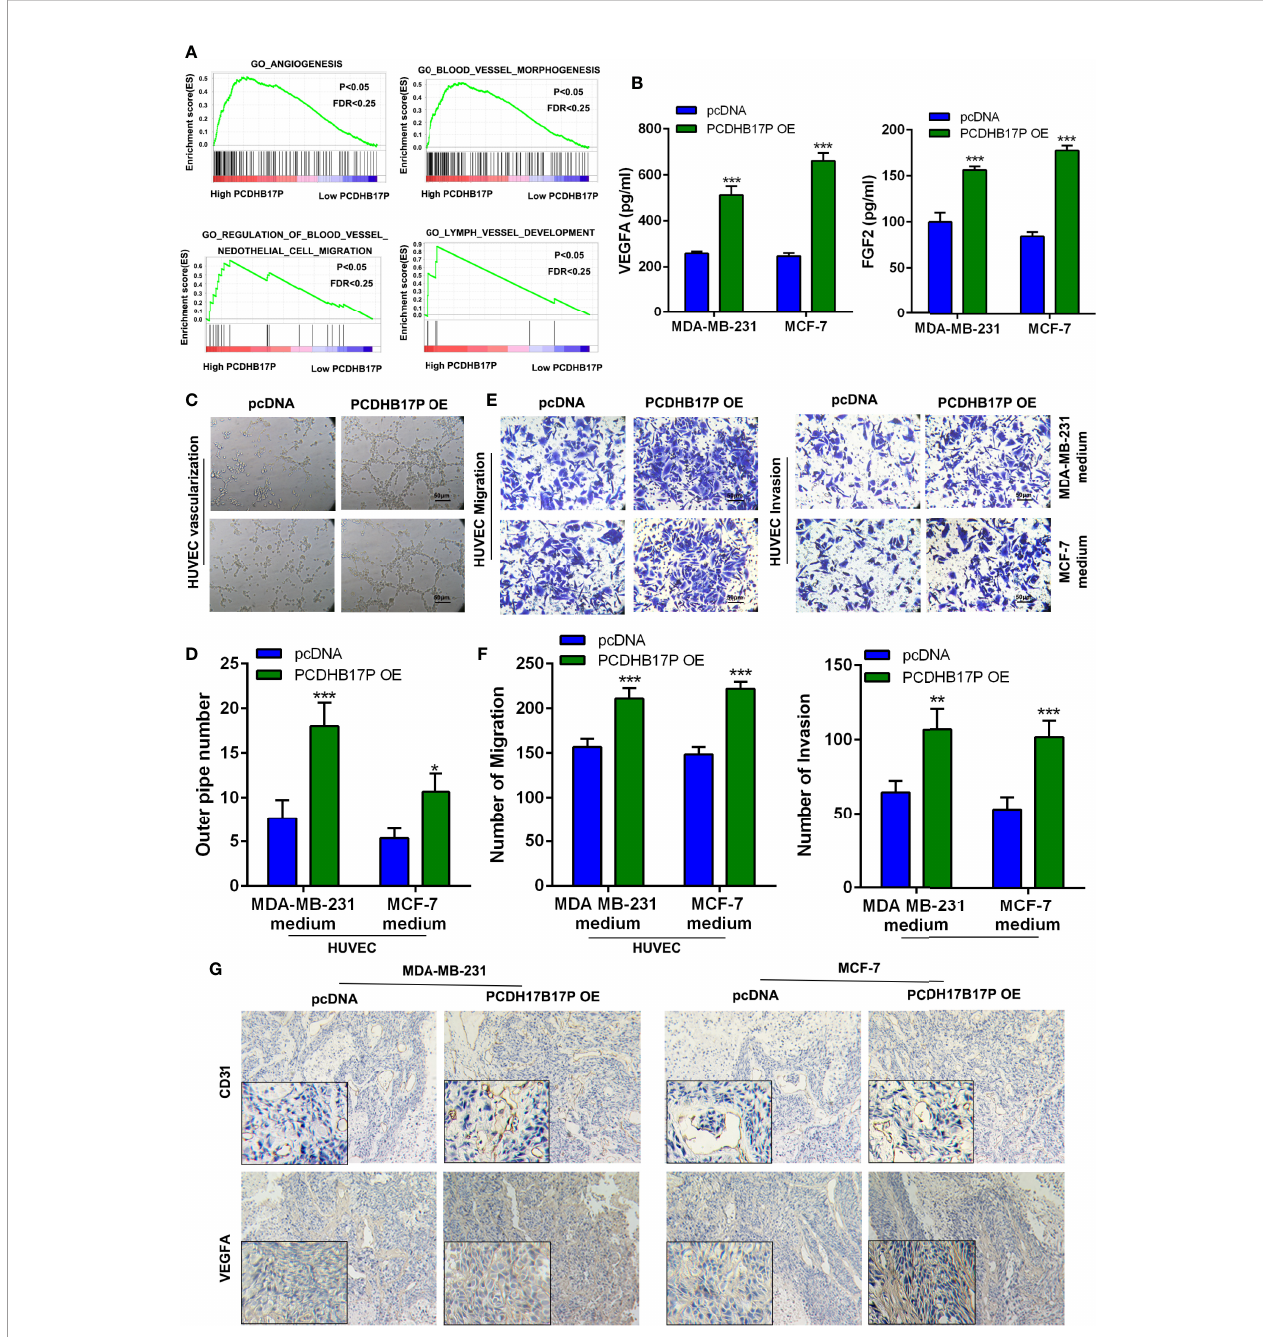
FIGURE 3 | PCDHB17P promotes angiogenesis of BRCA cells (A) GSEA revealed that PCDHB17P was related to angiogenesis in breast cancer. (B) The protein level of VEGFA and FGF2 in CM by ELISA assays. (C, D) Tube formation of HUVEC cell was detected and results were expressed as number of branches. (E, F) HUVEC cell migration and invasion were determined by transwell assay. (G) The expression of VEGFA and CD31 in the xenografts was examined by IHC. * P < 0.05, ** P < 0.01, *** P <